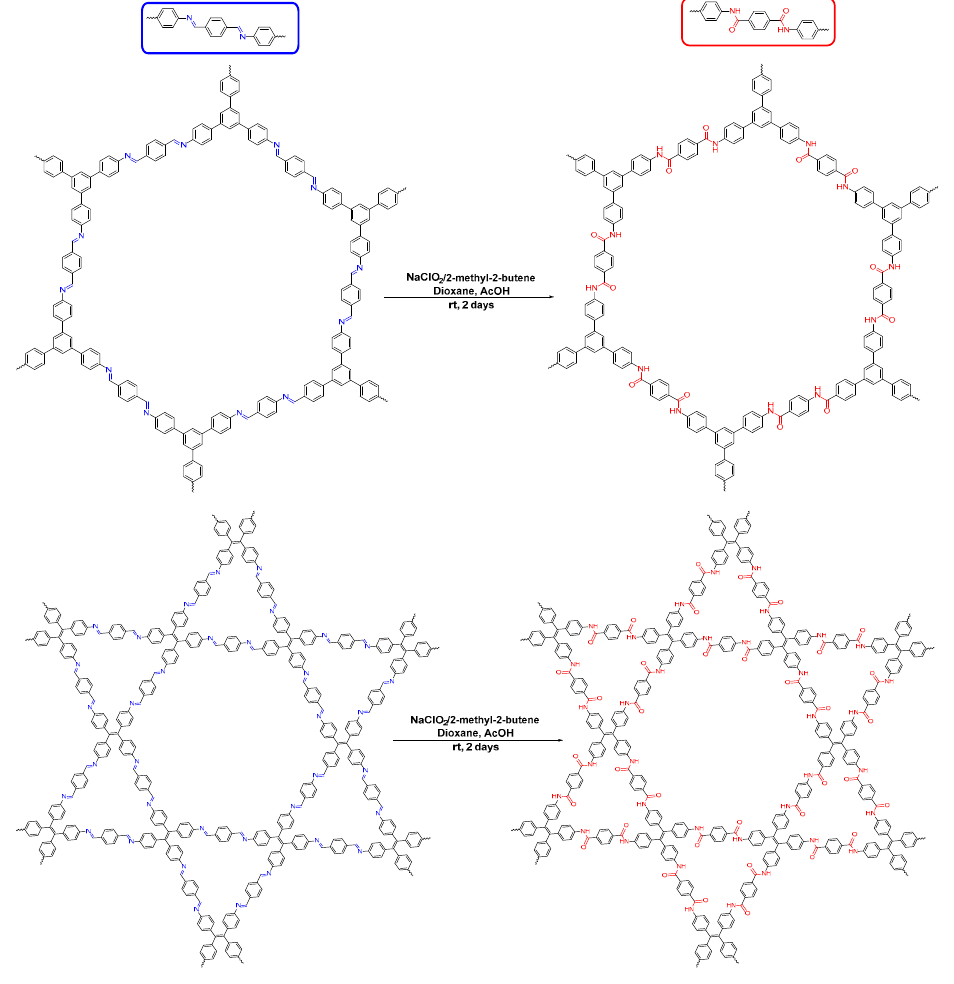
Figure 18. Construction of imide-linked COFs via post-oxidization of imine-linked COFs which bypass the difficulty of crystallization problem for irreversible imide bonds.